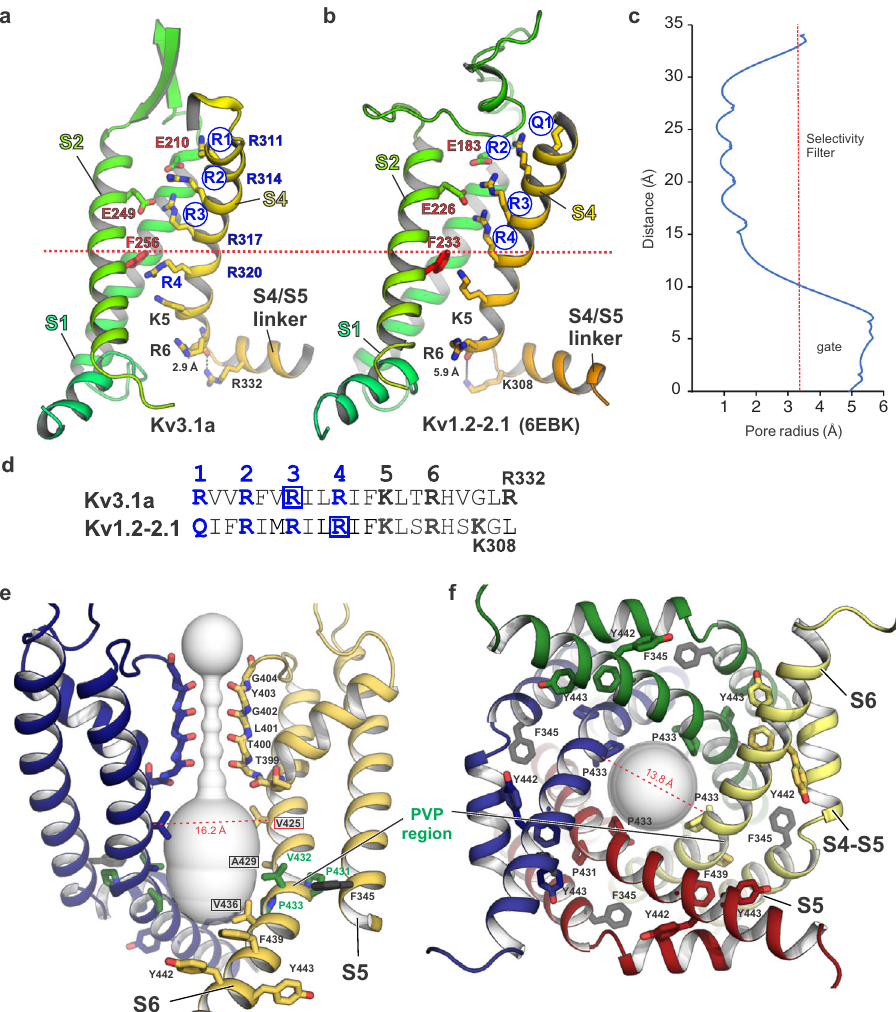
Fig. 3 Voltage sensor domain arrangement and pore properties of Kv3.1a. a Cartoon representation of the VSD S1 – S4 (S3 is omitted for clarity) in Kv31a, showing the relative positioning of the gating charges R1 – R4 (blue labelled) in S4 (shown in yellow) with respect to conserved residues (F256 and E249) of the hydrophobic charge transfer centre (CTC), located in S2 (shown in light green). Blue circles highlight voltage-sensing gating residues located above the position of conserved F256 of the CTC, which is represented by the dotted red line. b Cartoon representation of the VSD arrangement in Kv1.2-2.1 (pdb 6EBK), highlighting that all four voltage-sensing charges R1 – R4 (blue circles) are located above F233 compared to only three (R1 – R3) in Kv3.1a shown in panel ( a ). c Plot of the Kv3.1a pore radius, as determined by MOLE 77 . Red dotted line marks the radius of hydrated K + . d Sequence of S4 residues for Kv3.1a (top) and Kv1.2-2.1 (bottom) with the main voltage-sensing R/Q residues within the conserved arginine-rich motif highlighted in blue. Blue boxes encircle voltage-sensing arginines which are located above the CTC. e Cross-membrane view of the Kv3.1a pore domain and selectivity fi lter. For clarity, only two chains are shown. The pore diameter is shown as light grey surface representation. Residues in the PVP motif are shown as green sticks, major pore lining residues are highlighted by black frames. Conserved aromatic residues in the lower S6T gate are shown as sticks. F345 in S5 (unique to Kv3 family) is shown as black stick representation. Dashed line indicates c α distance between V425 (framed in red), a residue relevant for the gain-of-function mutation V425M associated with epileptic encephalopathy 15 . f Cytoplasmic view of the open pore with pore-lining S6 helices from all four subunits shown as cartoon representation. Dashed line indicates c α distance between P433 from two diagonal pore radius near the PVP region large enough to accommodate a with the positively charged side chain of R332 in the S4/S5 linker. hydrated K + ion (Fig. 3c, e, f). MD simulations con fi rm that the This interaction is absent in Kv1.2-2.1 because the respective S4/ S5 linker sequence lacks an arginine in this position and the pore is found in a stable conductive state, displaying a sustained nearby K308 side chain is too far away for a similar interaction hydration of the inner gate over MD simulation timescales (Fig. 3a, b, d). In the Kv4 subfamily, however, an analogous (Fig. S11a – c). Our maps also show densities in the selectivity fi lter stabilizing interaction could exist because the R332 residue in the which likely correspond to K + ions from the puri fi cation buffer (Supplementary Fig. S10a). Opening of the lower S6 gate however S4/S5 linker is conserved. This is con fi rmed by the recent full- is unexpected, because of the high activation potential of Kv3.1a length Kv4.2 structure 43 which indeed shows a salt bridge ( V 0.5 = + 8 mV, see Fig. 6d), and consequently only a small between the corresponding R6 (R305) carbonyl oxygen and the fraction of the channels (20 – 25%) should be activated at 0 mV. side chain of R311 in the S4/S5 linker (Fig. S12g). Since we observe distinct densities below the selectivity fi lter, it is Despite the less activated S4 position in the VSDs, the lower S6 possible that the lower gate of Kv3.1a is propped open by an gate of Kv3.1 is captured in a dilated conformation, exhibiting a